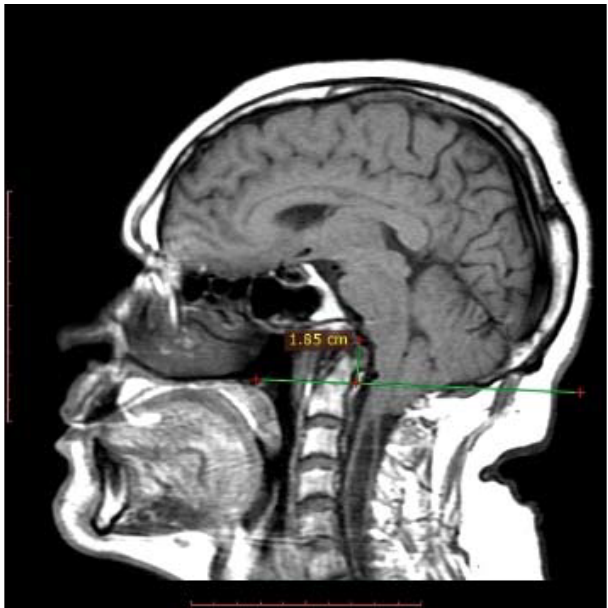
Figure 1 - The odontoid process crosses the Chamberlain line for 18.5 mm and compresses the pons anteriorly.